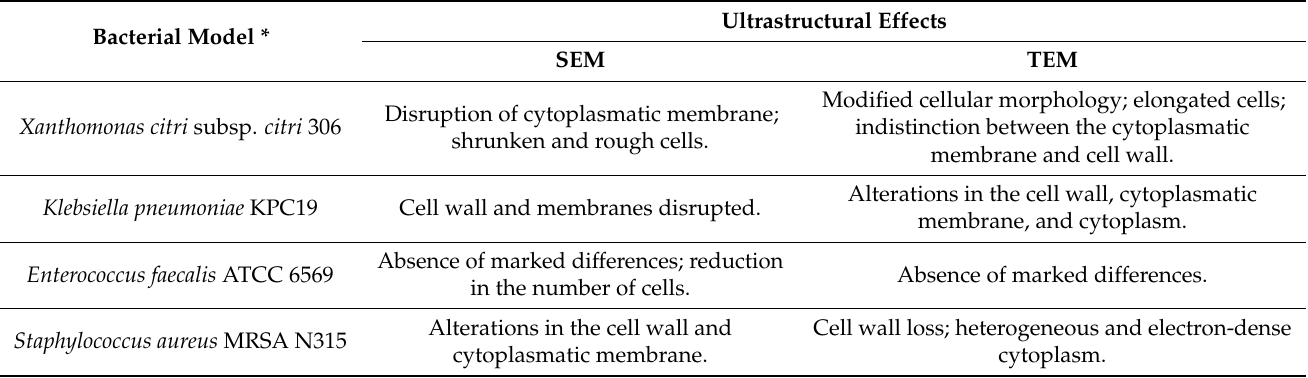
Table 4. Ultrastructural effects in microbial cells exposed to Fluopsin C and F4A fraction analyzed by scanning (SEM) and transmission electron microscopy (TEM). Ultrastructural Effects Bacterial Model * SEM TEM Modified cellular morphology; elongated cells; Disruption of cytoplasmatic membrane; indistinction between the cytoplasmatic shrunken and rough cells. membrane and cell wall. Alterations in the cell wall, cytoplasmatic Cell wall and membranes disrupted. membrane, and cytoplasm. Absence of marked differences; reduction Absence of marked in the number of cells.